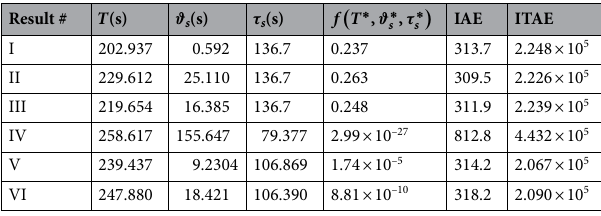
Table 2. SFOTDM parameter identification results.